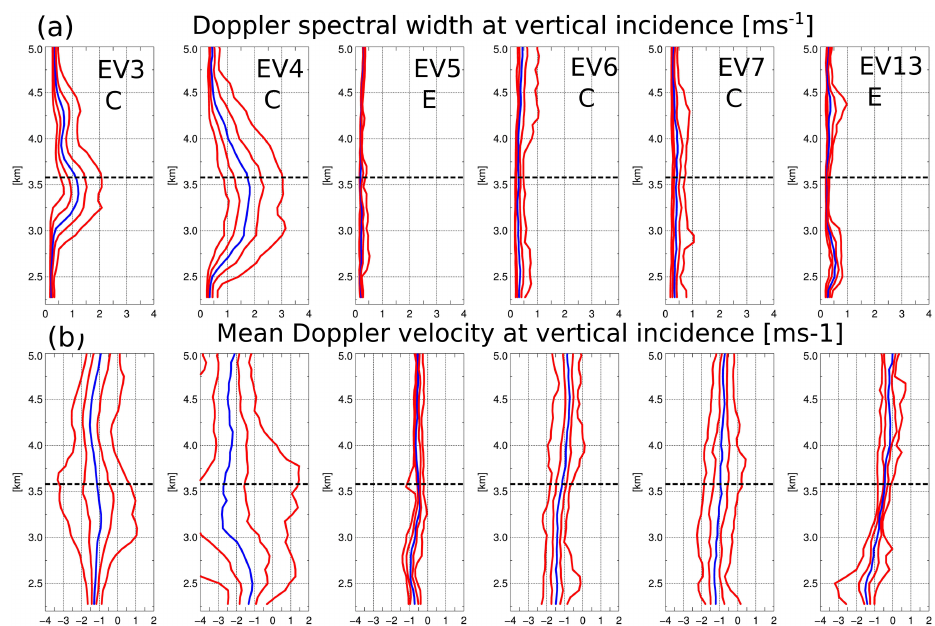
Figure 9. Vertical structure of (a) Doppler spectral width and (b) Doppler velocity over the whole duration of EV3, EV4, EV5, EV6, EV7, and EV13. Both variables are measured at vertical